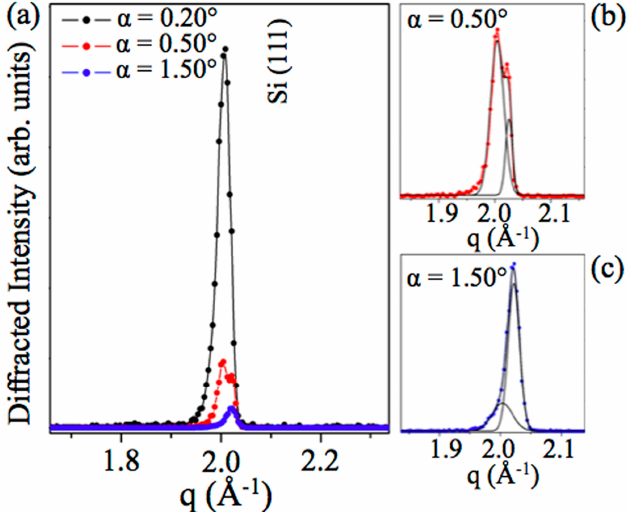
Figure 3. Energy dispersive out-of-plane rocking curves patterns from 10 MLs √ 3 × √ 3 Si film, grown on reconstructed Si(111) √ 3–Ag; ( a ) Si(111) diffraction peak (black dots) located at qz Si(111) = 2.003 (5) Å -1 ; Si(111) and multilayer silicene diffraction peaks located at q z 10 ML = 2.032 (5) Å -1 (red and blue dots). ( b ) and ( c ) are the expanded spectra from (a) with their Gaussian fits (black line).